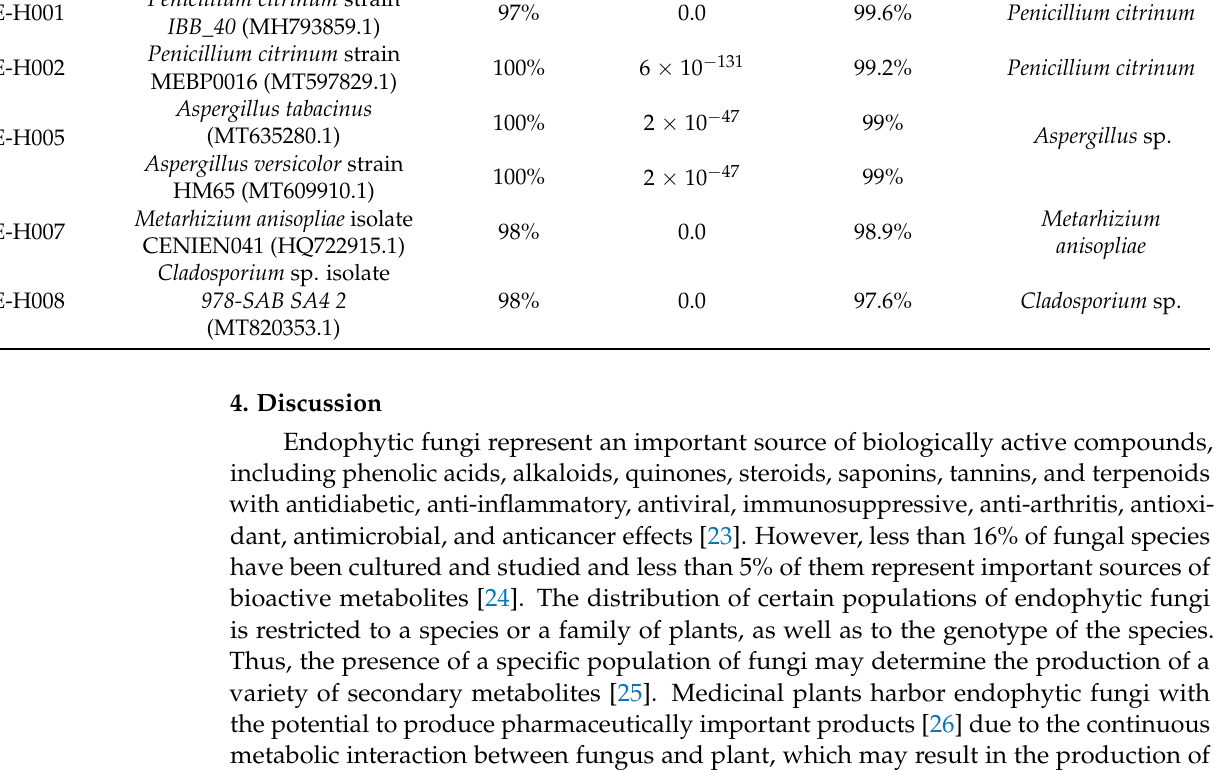
Table 3. Molecular identification based on ITS1/TS4 sequences of cytotoxic L. marginatus endophytic fungi. Isolate